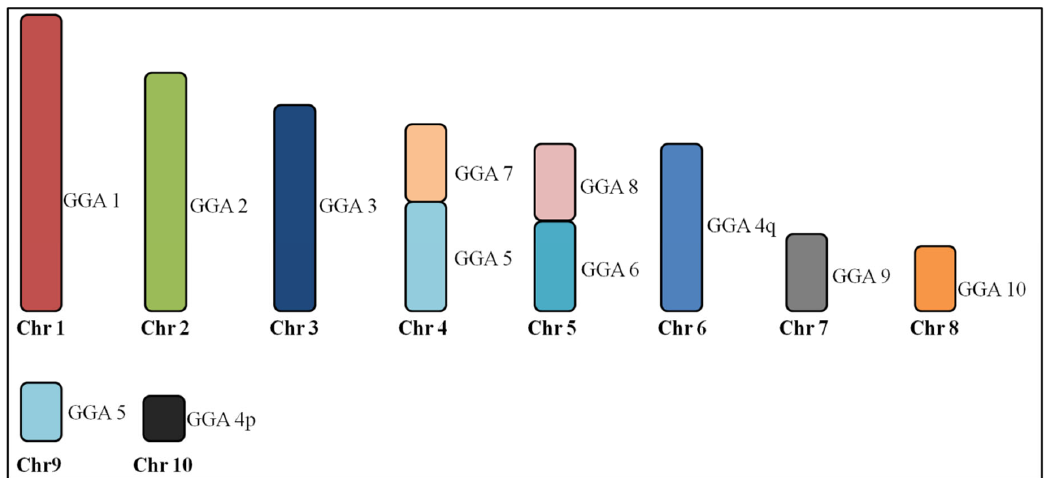
Figure 2. Homologous chromosomal segments of Gallus gallus (GGA) in Columbina talpacoti and Columbina passerina macrochromosomes as detected by fluorescence in situ hybridization (FISH) using GGA and Zenaida auriculata whole chromosome paints. Chr = Chromosome.